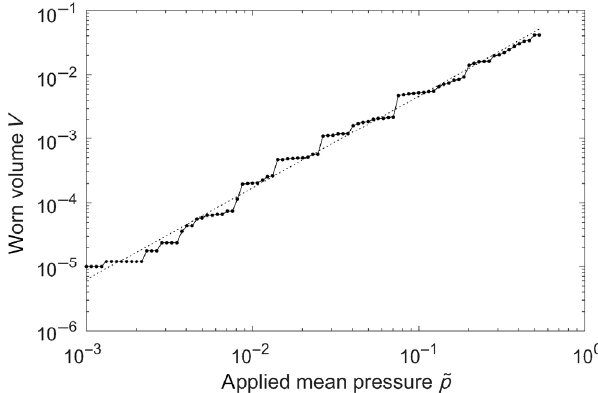
Fig. 9 Dependency of the settled worn volume as a function of the applied external load. In this case, the wear volume does not depend on the distance covered but occurs instantaneously for any given load, parameters as in Fig. 7.